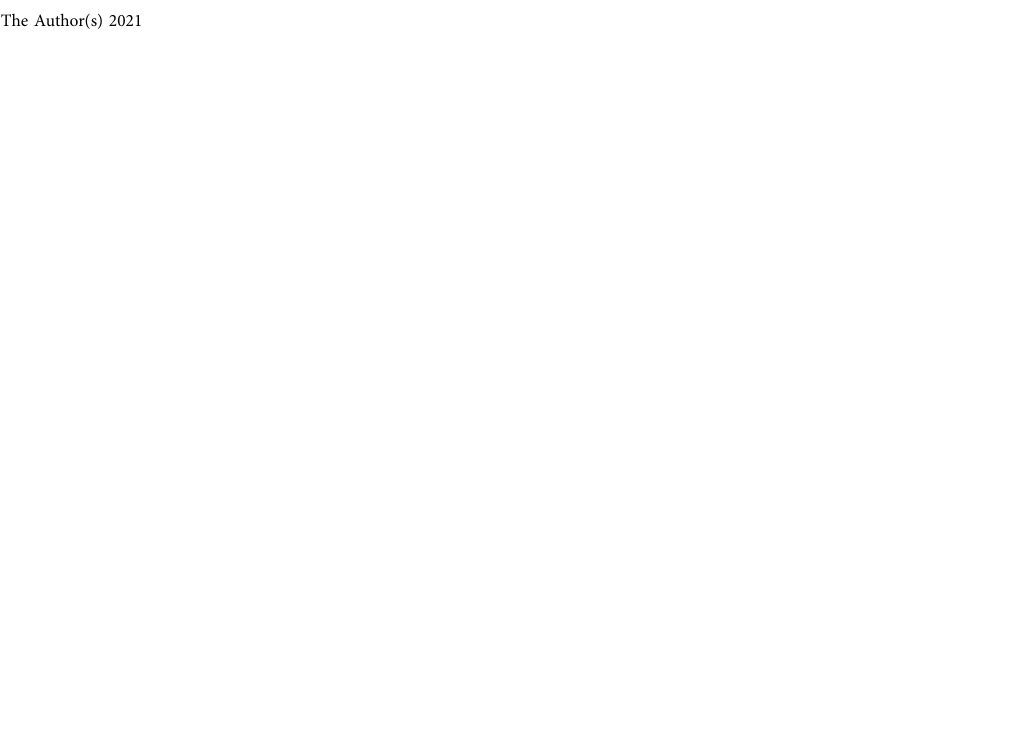
Figure 4 was missing from the PDF of this article. The original PDF has been corrected. The HTML version of the Article was correct at the time of